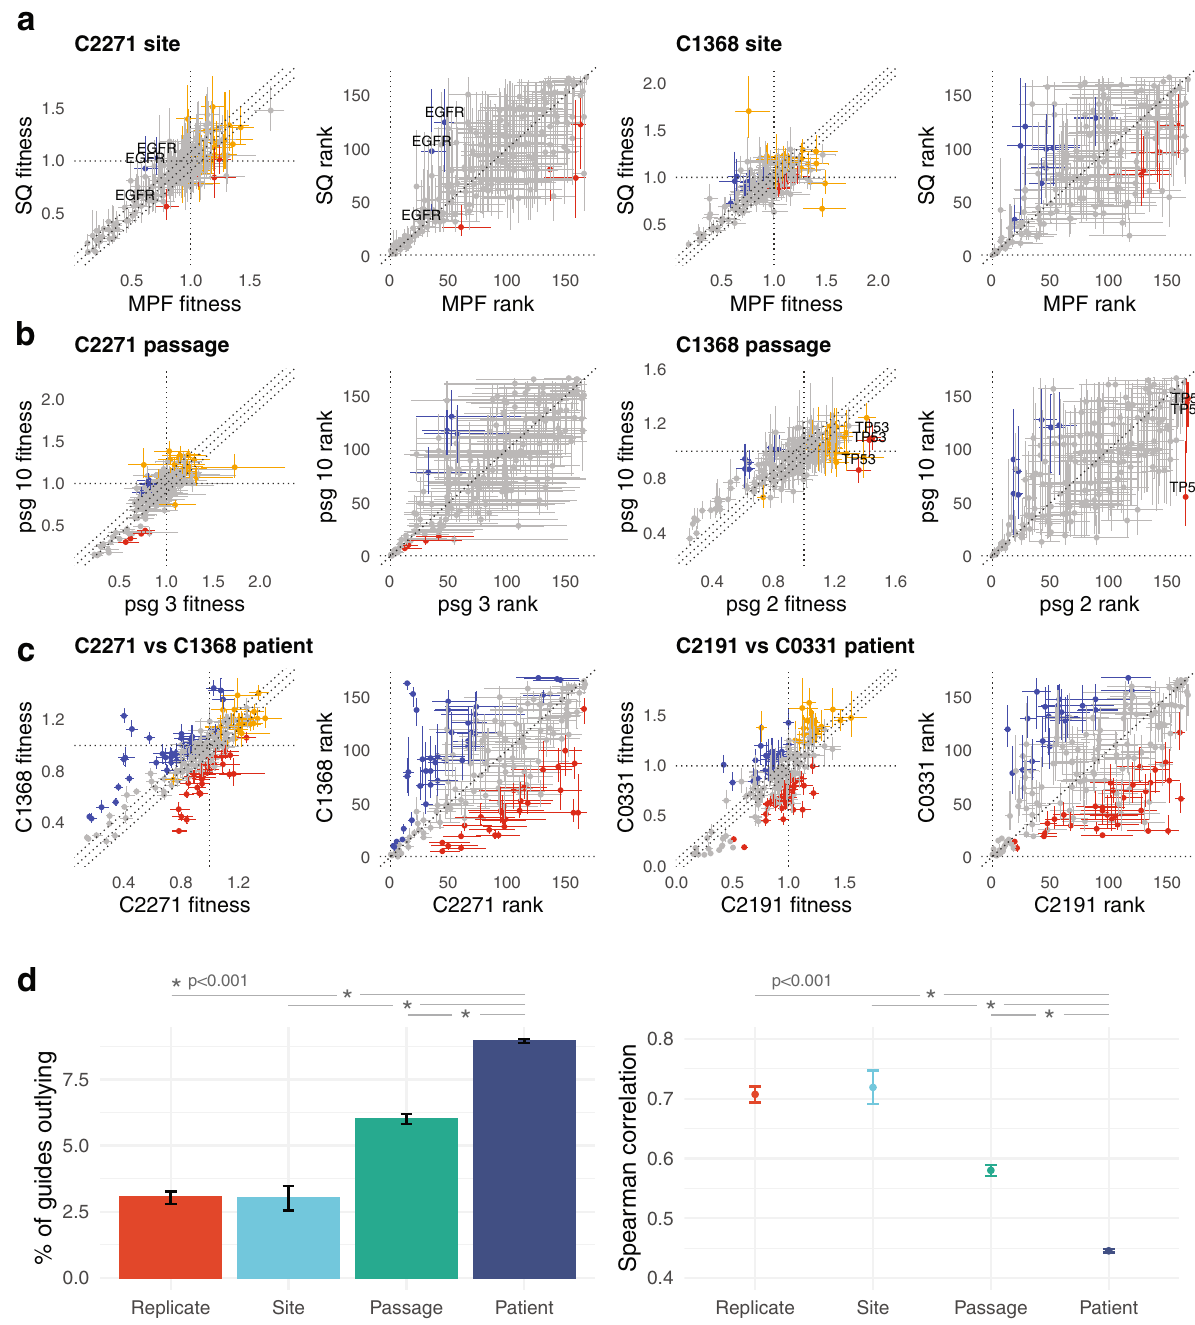
Fig. 4 Between-patient variation dominates in vivo gene fi tness. a Two examples comparing guide fi tness measurements (median, bars = 95% CI) between transplants of the same TNBC PDX material into subcutaneous (SQ) or mammary fat pad (MFP) sites. Red, blue: guide outliers between the two conditions satisfying criteria related to both fi tness and rank difference, and with more than one outlying guide targeting the same gene (Supplementary Methods). Orange: non-targeting control guides, shown in fi tness plots. (PDX tumours: C2271 n = 2, 1 for MFP, SQ; C1368 n = 2, 1 for MFP, SQ.) b Two examples comparing guide fi tness measurements (median, bars = 95% CI) between transplants of an early and late passage from the same TNBC PDX line. Criteria for identifying outlying guides as in a . (PDX tumours: C2271 n = 3, 3 for early, late; C1368 n = 3, 2 for early, late.) c Two examples comparing guide fi tness measurements (median, bars = 95% CI) between transplants of PDX lines from different patients. Criteria for identifying outlying guides as in a . (PDX tumours: n = 3, 3, 4, 3 for C2271, C1368, C2191, C0331.) d Left panel shows the percentage of guides satisfying outlying criteria for all pairs of datasets that represent biological replicates; site comparisions; early vs late passage comparisons; and comparisions between different patient PDX lines. Right panel shows the Spearman rank correlation of guide fi tness for the same sets of comparisons. Bars display mean + / − SEM ( p < 0.001 two-sided for all pairs, except for Replicate-Site, in both panels). Both metrics show greatest dissimilarity in fi tness for comparisons involving different patients. ( n = 249, 30, 496 and 4624 pairwise comparisons for replicate, site, passage, patient). Source data are provided as Source Data fi